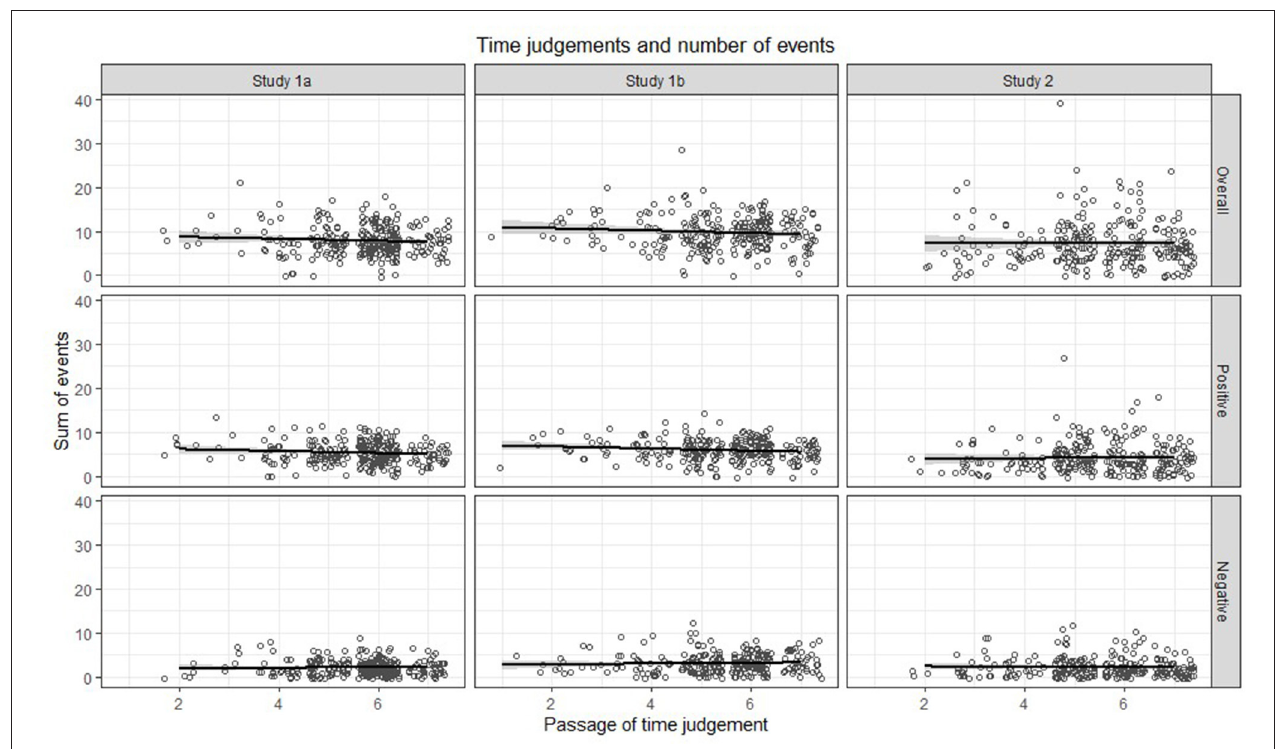
FIGURE 5 | Associations between the total number of events/memories as well as the number of positive and nevative events/memories with Passage of Time Judgments for the last 5 years.